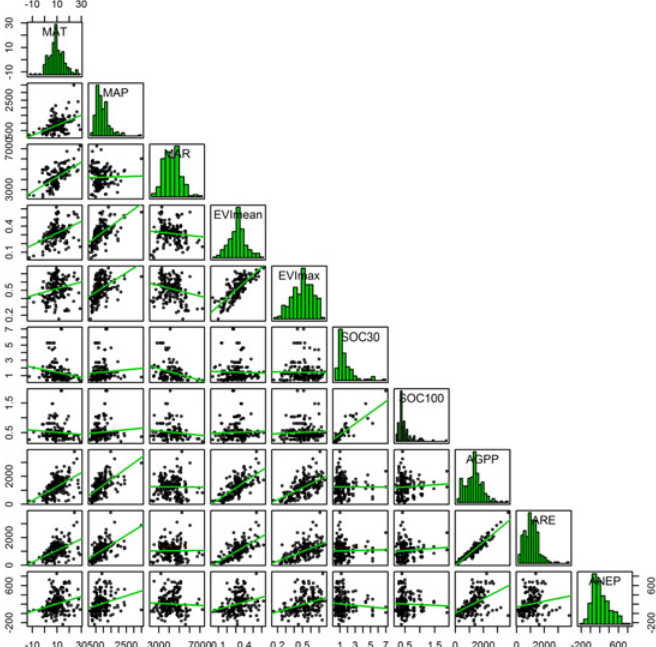
Fig 2. Scatterplot matrix of climate, vegetation, soil factors and ecosystem carbon dioxide fluxes. The diagonal panels were histograms of each factor and carbon dioxide flux. The lower panels were linear regression for each pair of factor and carbon dioxide flux. MAT: mean annual temperature (°C); MAP: mean annual precipitation (mm); MAR: mean annual solar radiation (W m -2 ); EVI max : mean maximum enhanced vegetation index; EVI mean : mean annual enhanced vegetation index; SOC 30 : soil organic carbon content at the depth of 0 – 30 cm (%); SOC 100 : soil organic carbon content at the depth of 30 – 100 cm (%); AGPP: mean annual gross primary production (g C m -2 yr -1 ); ARE: mean annual ecosystem respiration (g C m -2 yr -1 ); ANEP: mean annual net ecosystem production (g C m -2 yr -1